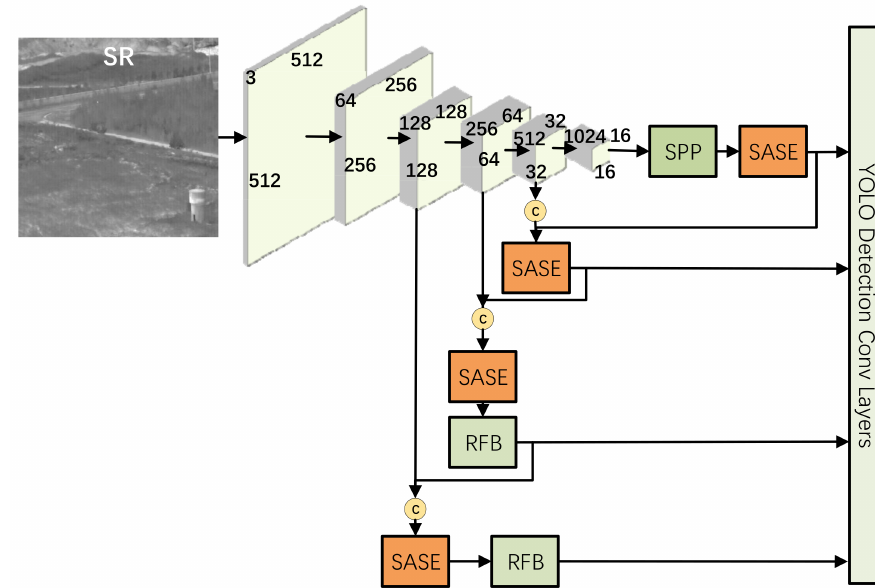
Figure 3. Network structure diagram.